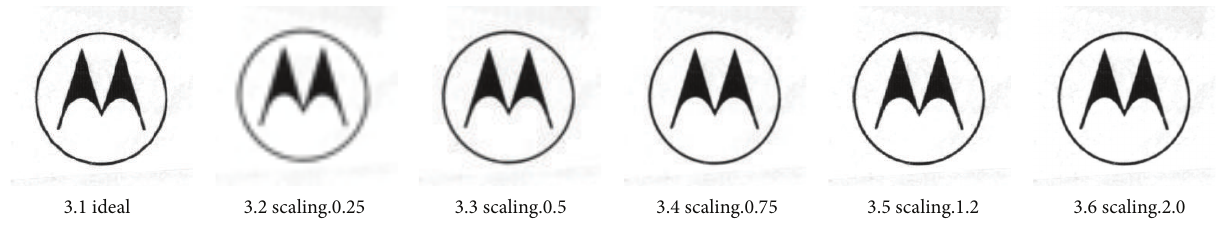
Figure 3: Logos with scaling.